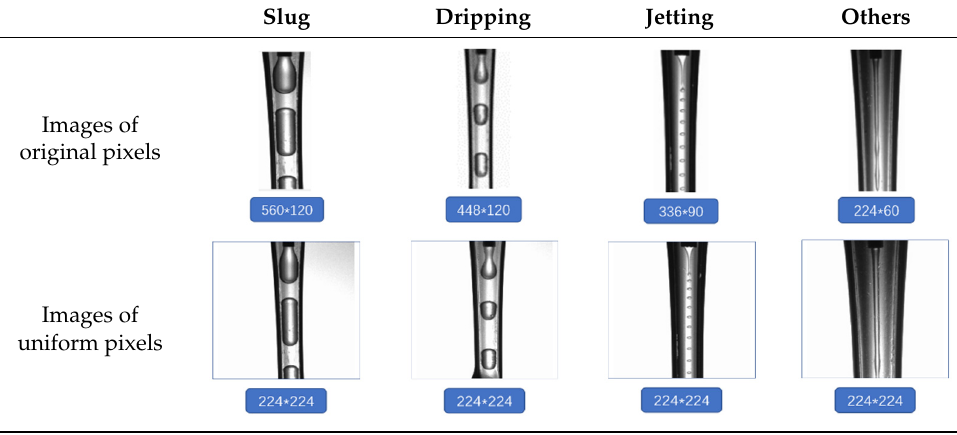
Table 3. Original pixels transformed into uniform pixels.